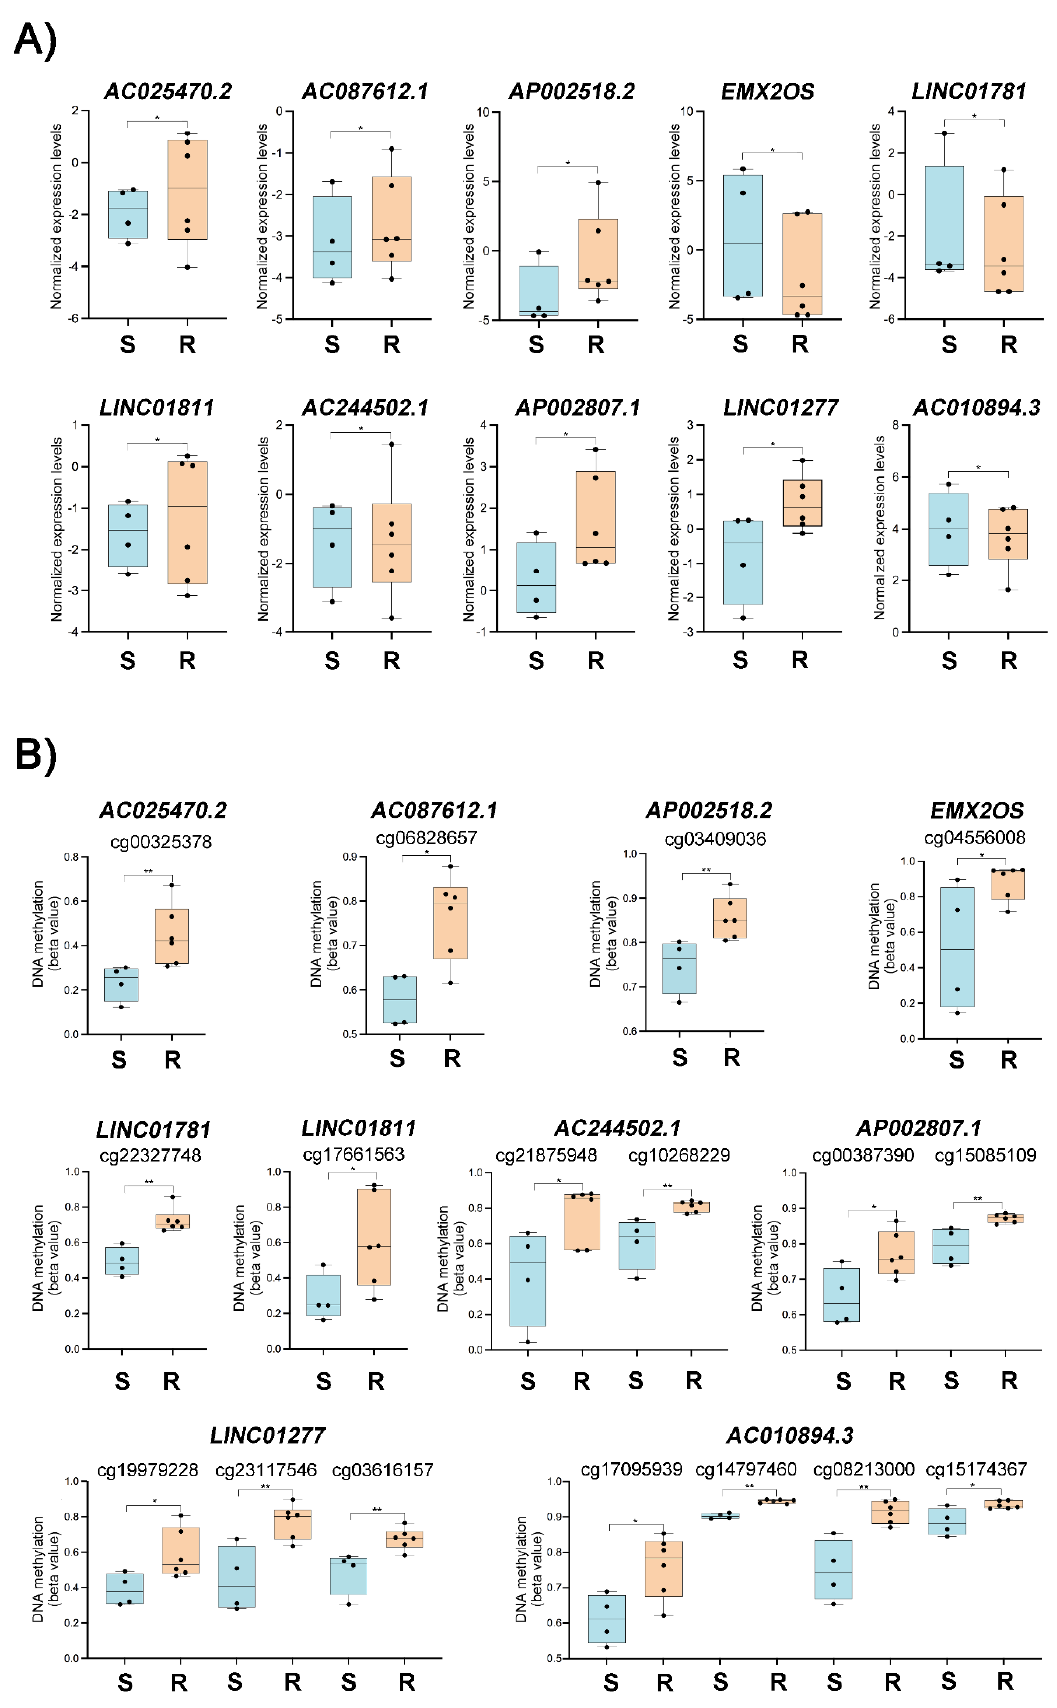
Figure 2. lncRNAs associated with carboplatin resistance in ovarian cancer (OC) cell lines. ( A ) Ex- pression levels of ten out of eleven selected long non-coding RNAs were detected as